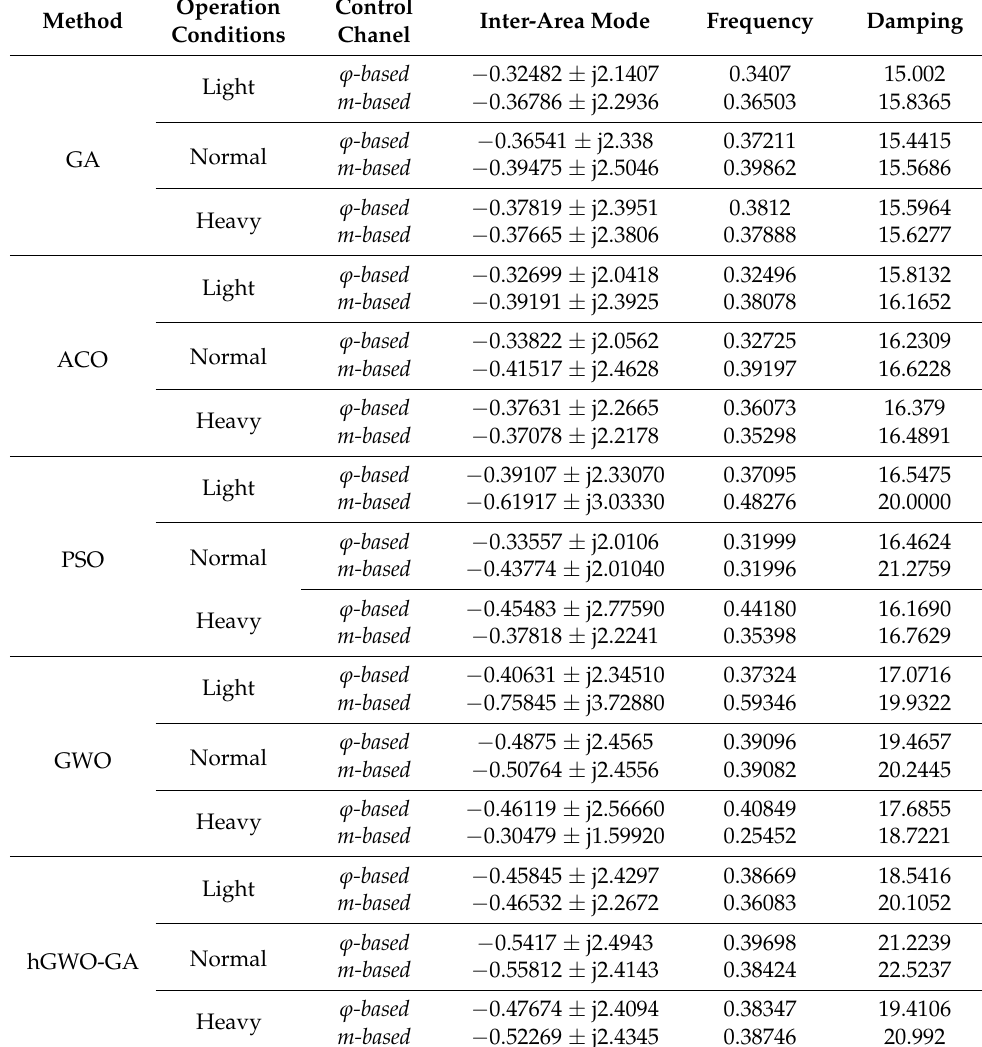
Table 7. Inter-area mode for the closed-loop system in the robust